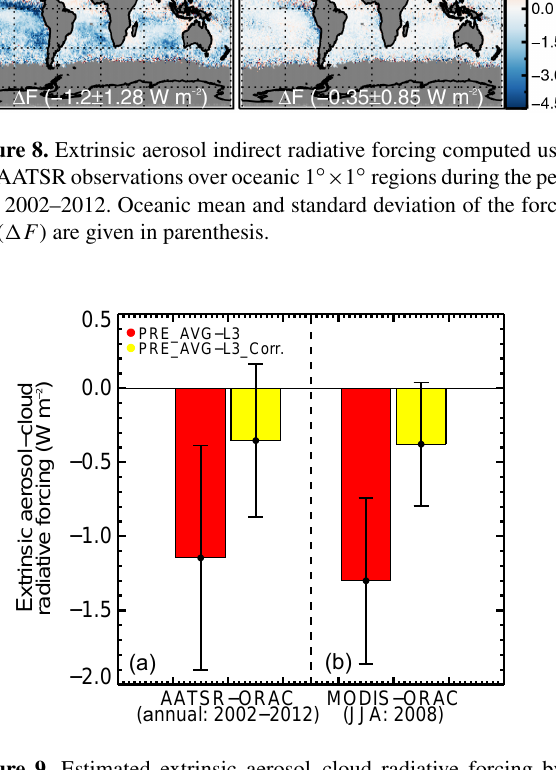
Figure 9. Estimated extrinsic aerosol–cloud radiative forcing by global marine warm clouds derived using top of atmosphere short- wave fluxes from AATSR-ORAC (a) and MODIS–ORAC (b) . Esti- mates are provided using the pre-average standard level-3 products (PRE_AVG-L3 composite; red), and pre-average corrected level-3 products in which the nearest aerosol is located at least 15km from any other cloud (PRE_AVG-L3_Corr.; yellow). Error bars are cal- culated on the basis of the standard error of the regression